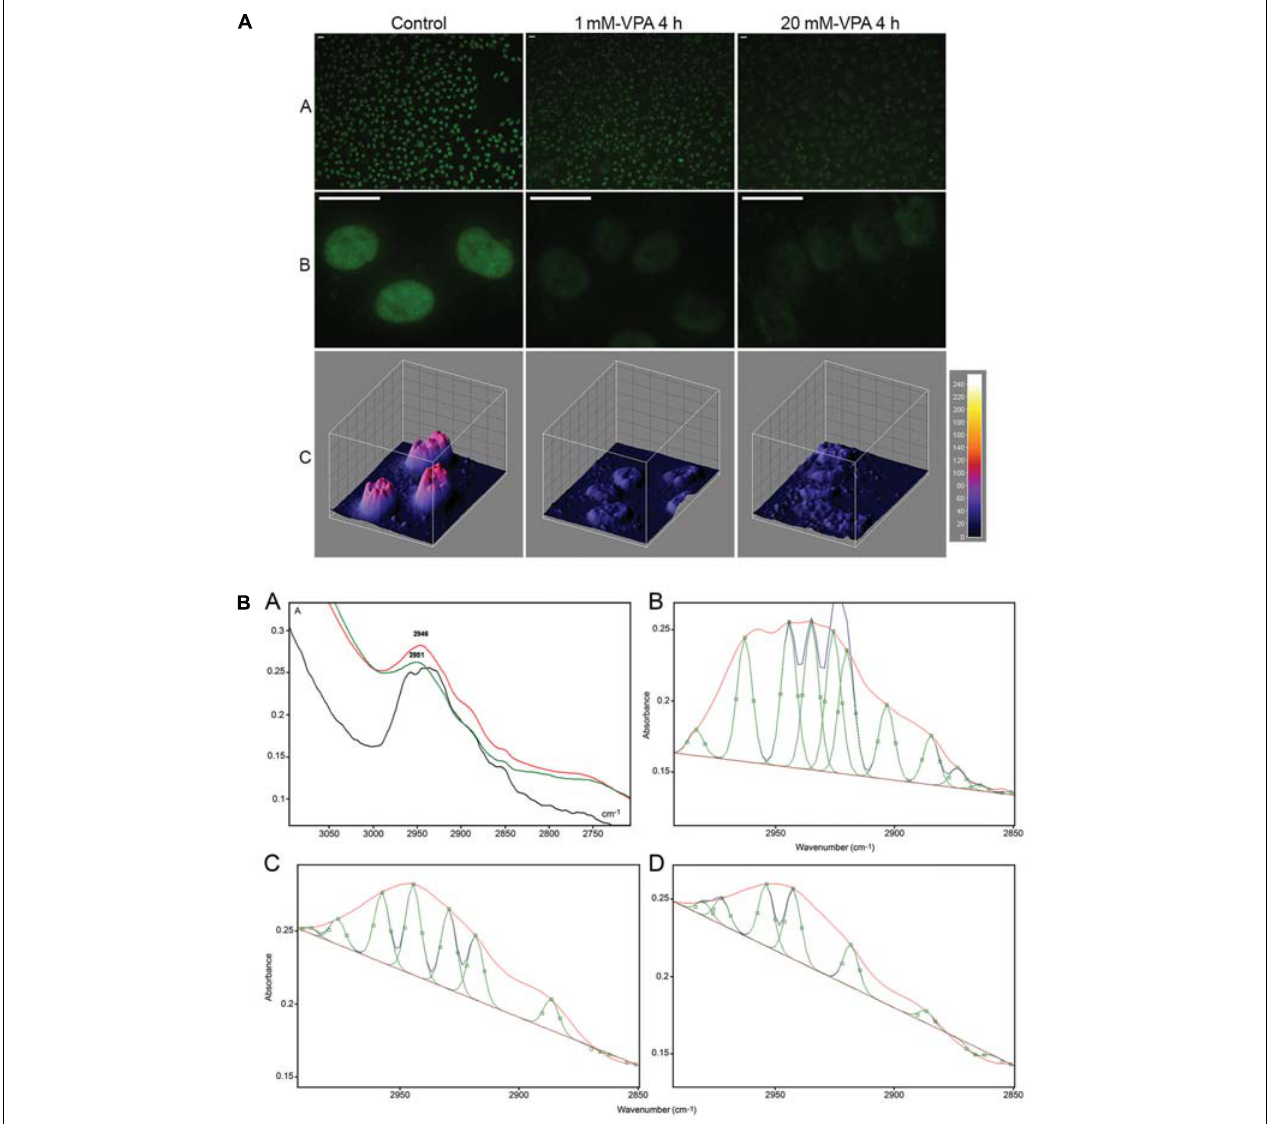
FIGURE 2 | Immunofluorescence signals (A) and FTIR spectral window in the 2,990–2,850 cm − 1 wavenumber range (B) for DNA 5mC of HeLa cells cultivated in the presence of VPA. In panel (A) , reduction in the DNA 5mC fluorescence signals is shown as assessed visually (A,B) and from images obtained with the ImageJ 3D plugin software (C) . In panel (B) , the area under the band contributed by -CH 3 signals, which decreases with increasing VPA concentration, is evident in the original normalized spectra (A) and after the peak fitting process provided by the Grams/AI 8.0 software [ (C) (1 mM VPA) and (D) (20 mM VPA)] compared to the untreated control (B) . In the original spectra shown in panel (A) , the curve for the untreated control is represented by the black line, whereas the curves for 1 and 20 mM VPA-treated cells are represented by the red and green lines, respectively [reprinted from Veronezi et al. (2017). PLoS ONE 12(1): e0170740].